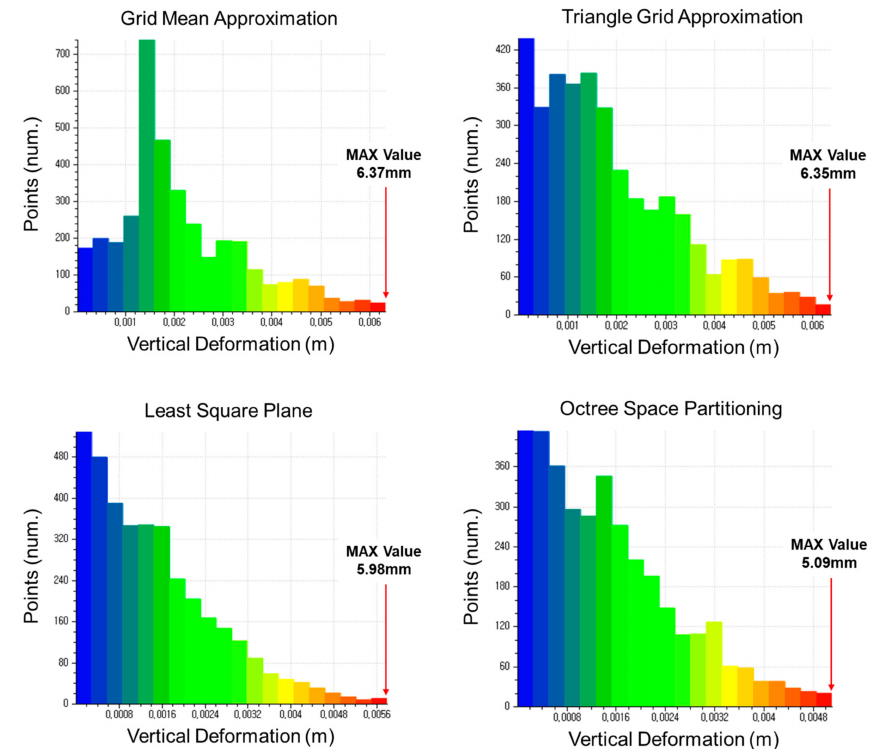
Figure 9. Classification of vertical displacement of the 12 mm specimen (LC4).